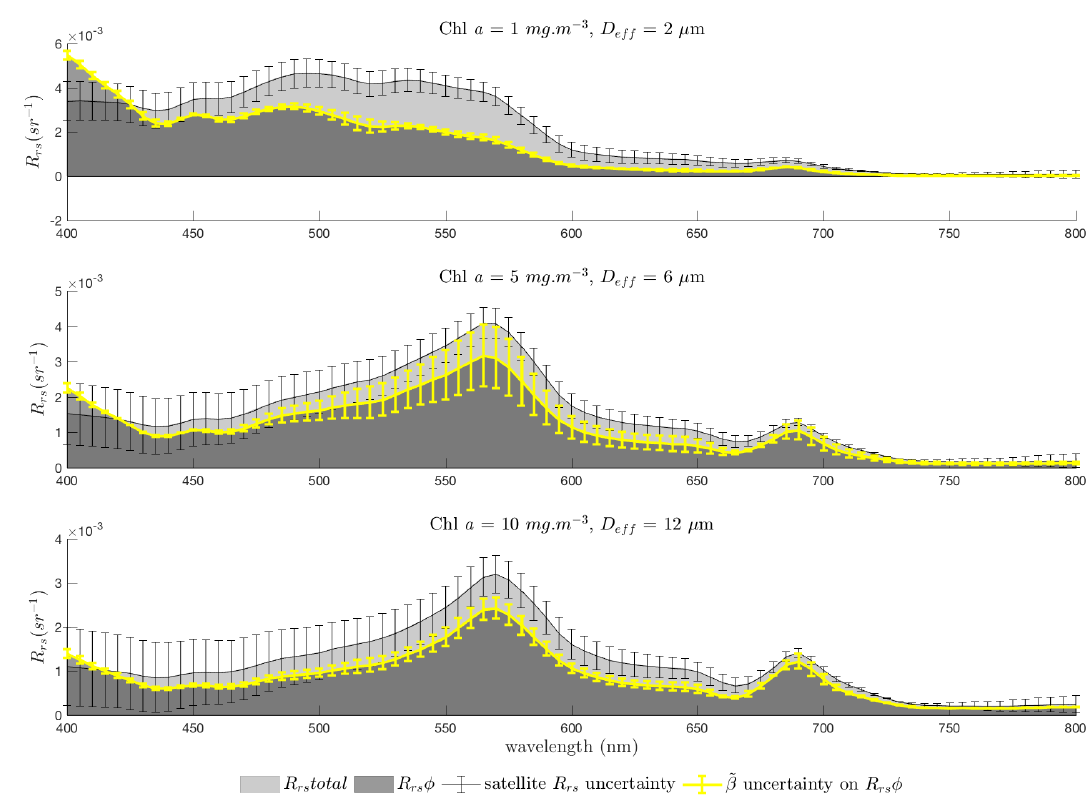
Figure A6. Total R rs with satellite measurement uncertainties in the blue and red bands from [16] and linearly interpolated between them. An indication of model uncertainty on the R rs φ is calculated by the spectral differences resulting from the use of a combined b bp ( λ ) -specific Fournier Forand phase function independent of wavelength, vs. wavelength- and b b φ ( λ ) -dependent EAP phase